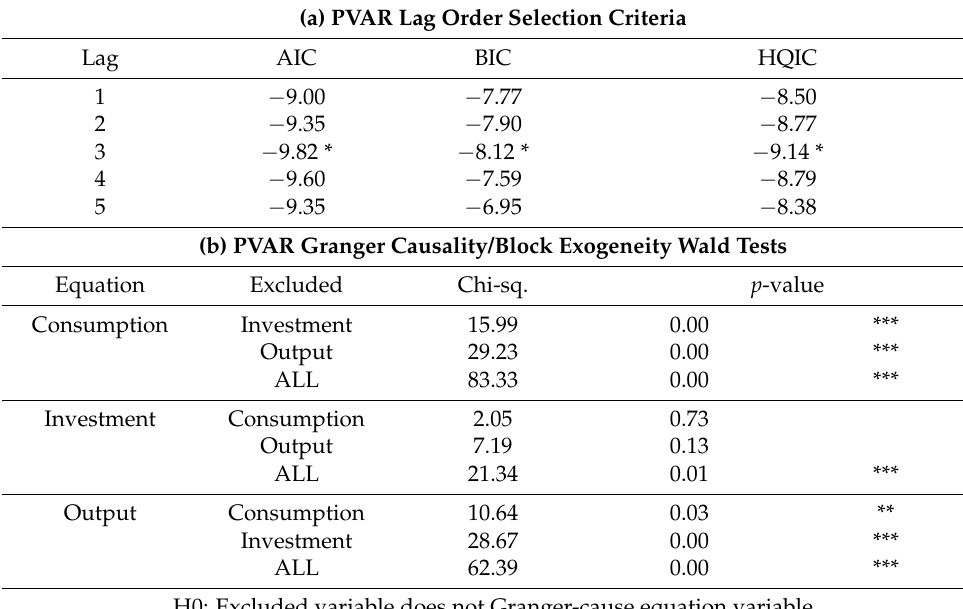
Table 5. PVAR setting tests.